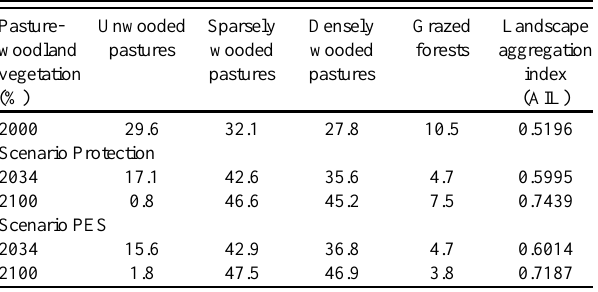
Table 4 . Percentage of pasture woodland vegetation types and landscape aggregation index in 2000, 2034 and 2100 in the two policy scenarios for La Bullatonne (1300 m a.s.l. extensive use). PES = Payment for environmental